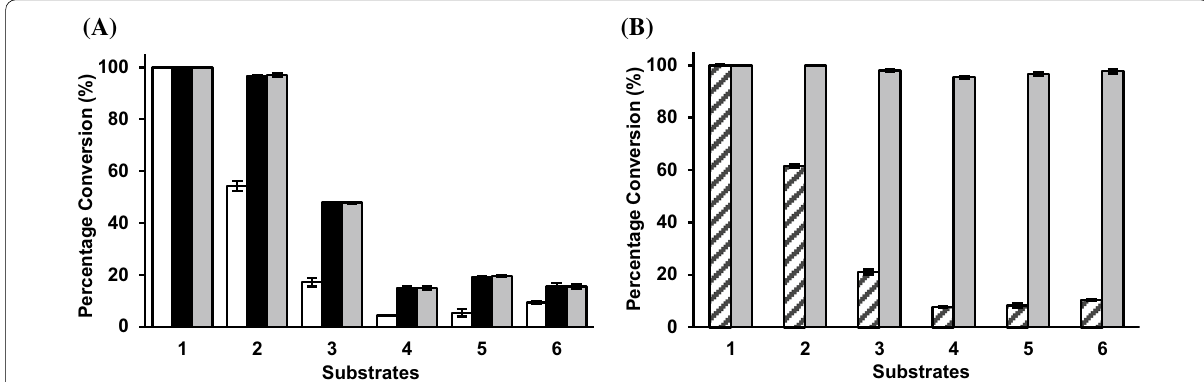
Fig. 7 Substrate specificities of ∆22Bt3590 at 37 °C ( A ) or 30 °C ( B ) using GlcNAcαMU ( 1 ) and synthetic α‑GlcNAc‑terminated fluorescent‑tagged heparosan oligosaccharides of varied lengths ( 2–6 , Fig. 4) as potential substrates. Reaction times vary from 20 min (white columns), 1 h (patten filled columns), 4 h (black columns), to 24 h (gray